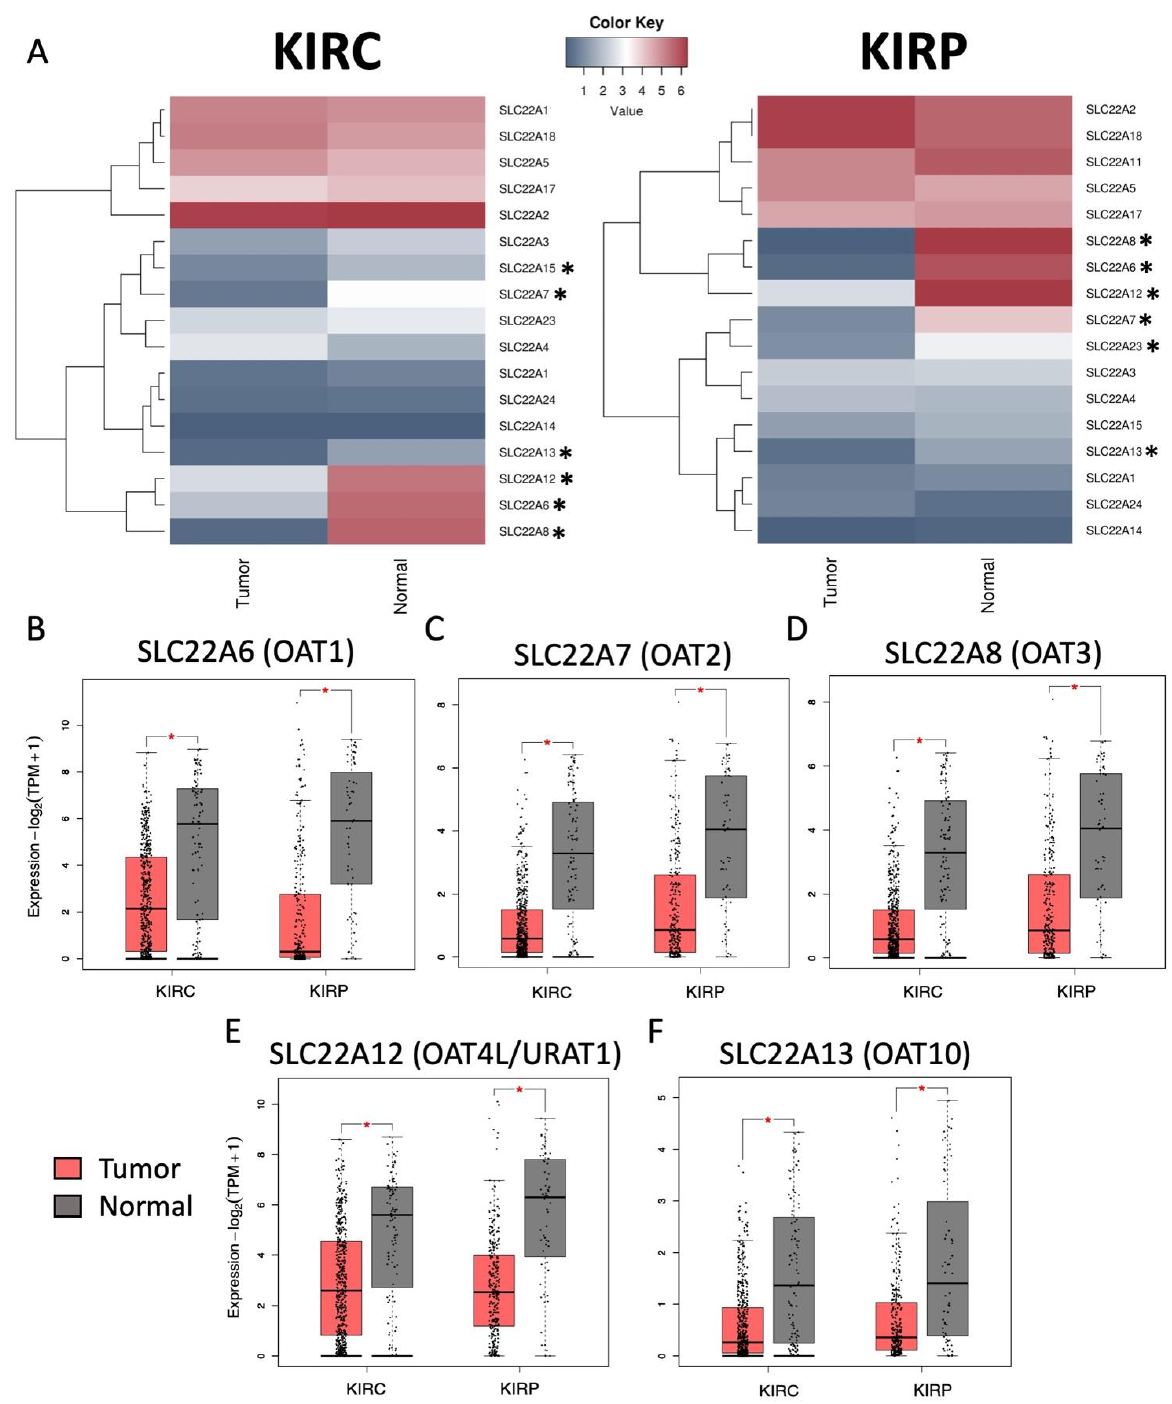
Figure 1. SLC22 gene expression changes between normal kidney tissue and KIRC and KIRP tumors. ( A ) Heatmaps generated by RNA-Seq data collected from the GEPIA tool showing all expressed SLC22 genes in KIRC (left; num(Tumor) = 523; num(Normal) = 100) and KIRP (right; num(Tumor) = 286; num(Normal) = 60) tumors or normal kidney based on average transcripts per million reads (TPM). Tumor sample data is based on the TCGA cohort and normal kidney samples include matched tissue from TCGA and the GTEX cohorts. Asterisks indicate differentially ex- pressed (DE) genes between tumor and normal with 5 out of 7 DE genes shared between the tumor comparisons. Expression boxplots generated using the GEPIA2 tool compare the expression distri- bution (with individual points representing patient samples) in primary KIRC and KIRP tumors